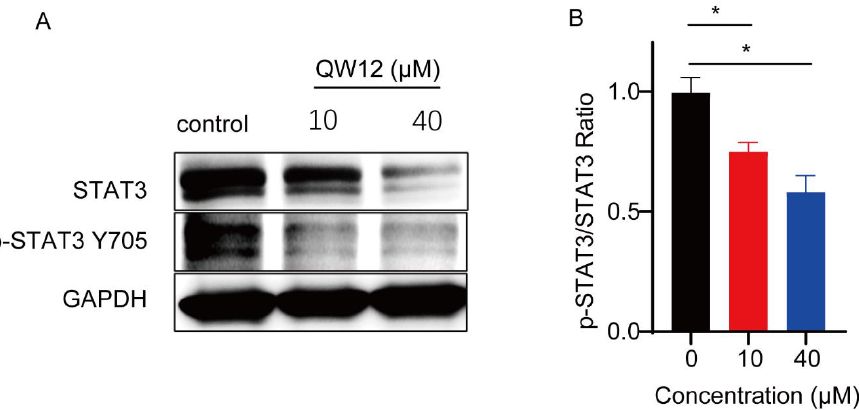
Figure 8. QW12 inhibits STAT3 phosphorylation ( A ) QW12 inhibits the phosphorylation level of STAT3 (Y705). ( B ) Quantitative statistics of the results in A using ImageJ software. Values are presented as means ± SD of three independent experiments. * p <